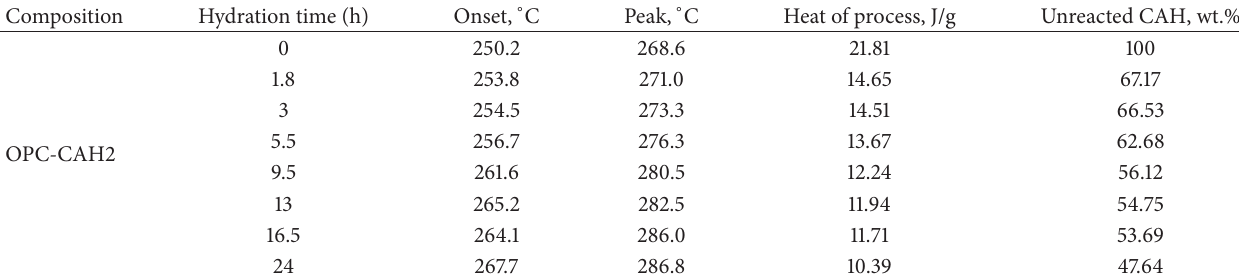
Table 2: The main characteristics of thermal effects typical of CAH.